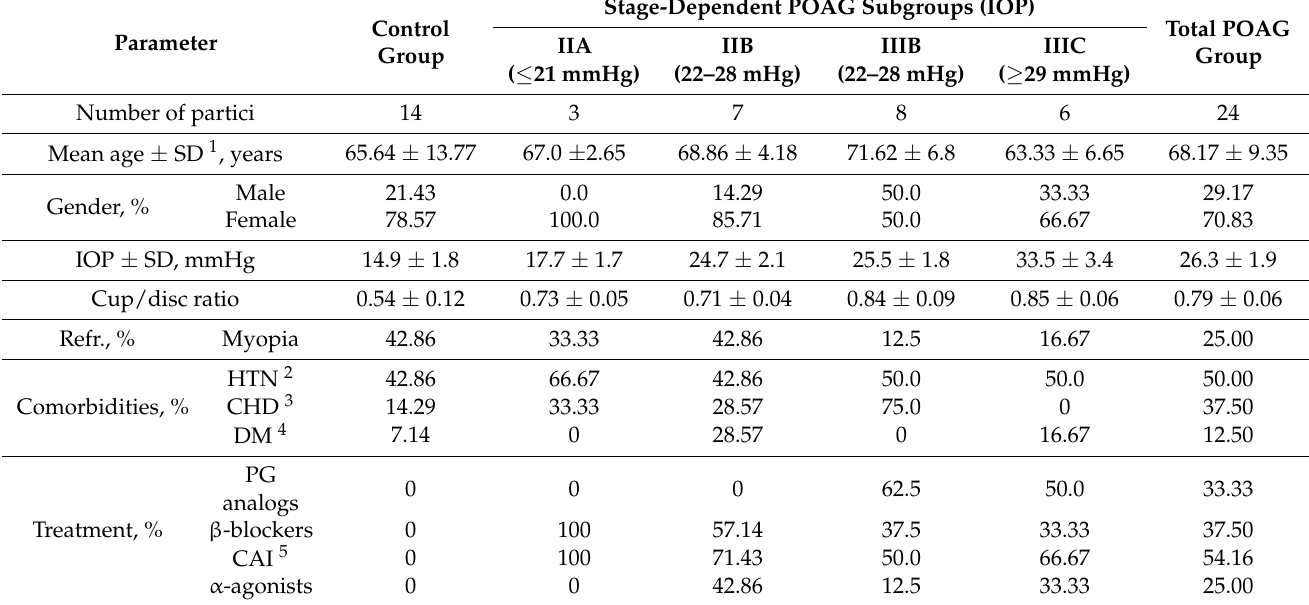
Table 1. Characteristics of control and POAG